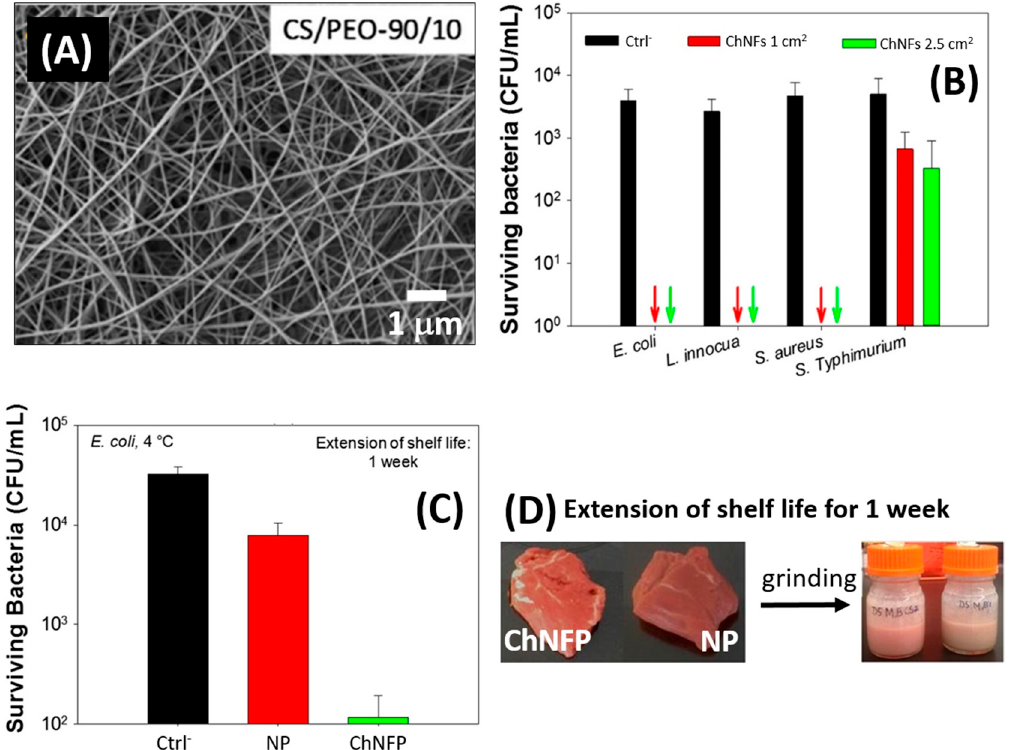
Figure 2. ( A ) An SEM picture of electrospun chitosan-PEO nanofibers (ChNFs) obtained from a 90/10 ( w/w ) solution in 50% acetic acid. ( B ) In vitro antibacterial activity of 1-cm 2 and 2.5-cm 2 swatches of ChNFs against E. coli , L. innocua , S. aureus , and S. Typhimurium compared to a negative control membrane (Ctrl − ). The arrows indicate total inhibition of E. coli , L. innocua , and S. aureus growth. The wider the area of ChNFs (i.e., larger chitosan content), the better the effect against S. Typhimurium. ( C ) In situ antibacterial activity of ChNFs-based packaging (ChNFP) against E. coli compared to negative control (Ctrl − ) of inoculated meat and positive control of inoculated meat wrapped in neat conventional packaging (NP) after seven days of raw meat storage at 4 °C. ( D ) Appearance of red meat wrapped in ChNFP and NP one week before and after grinding. Reprinted with permission from [66] , copyright 2018 Wiley.